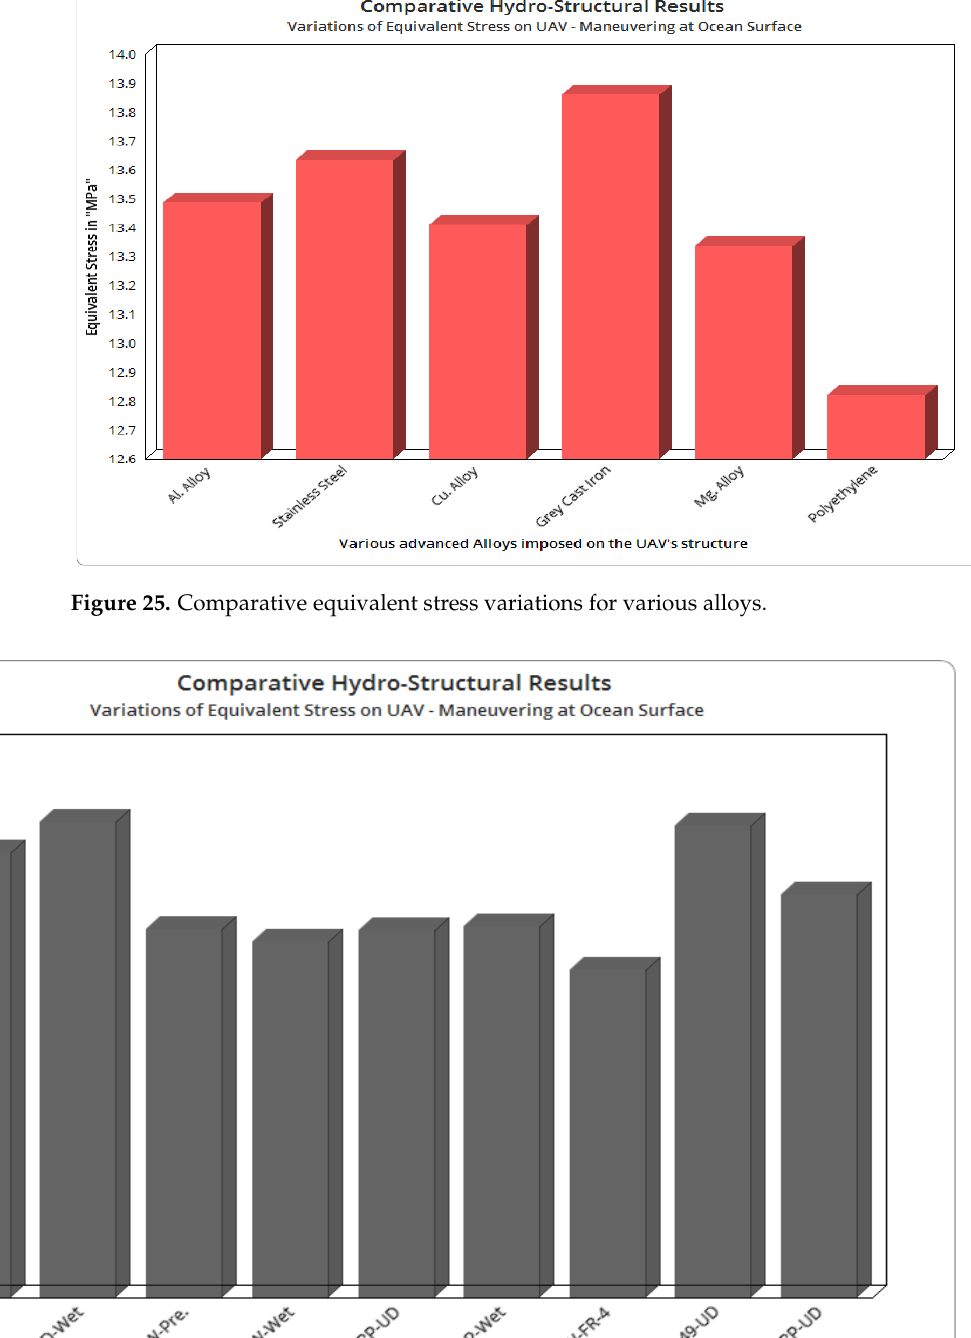
Figure 26. Comparative equivalent stress variations for various composites.